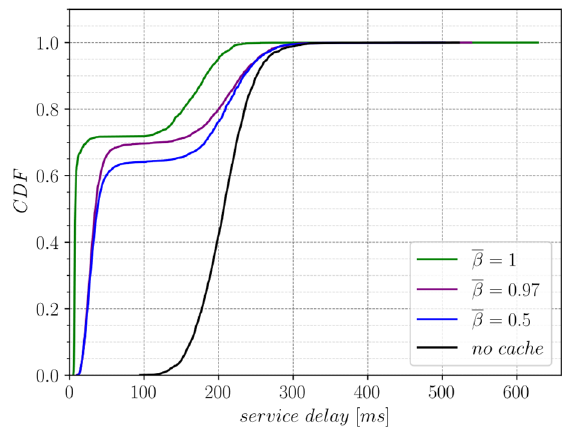
Figure 14. Service delay for λ = 1/180 s − 1